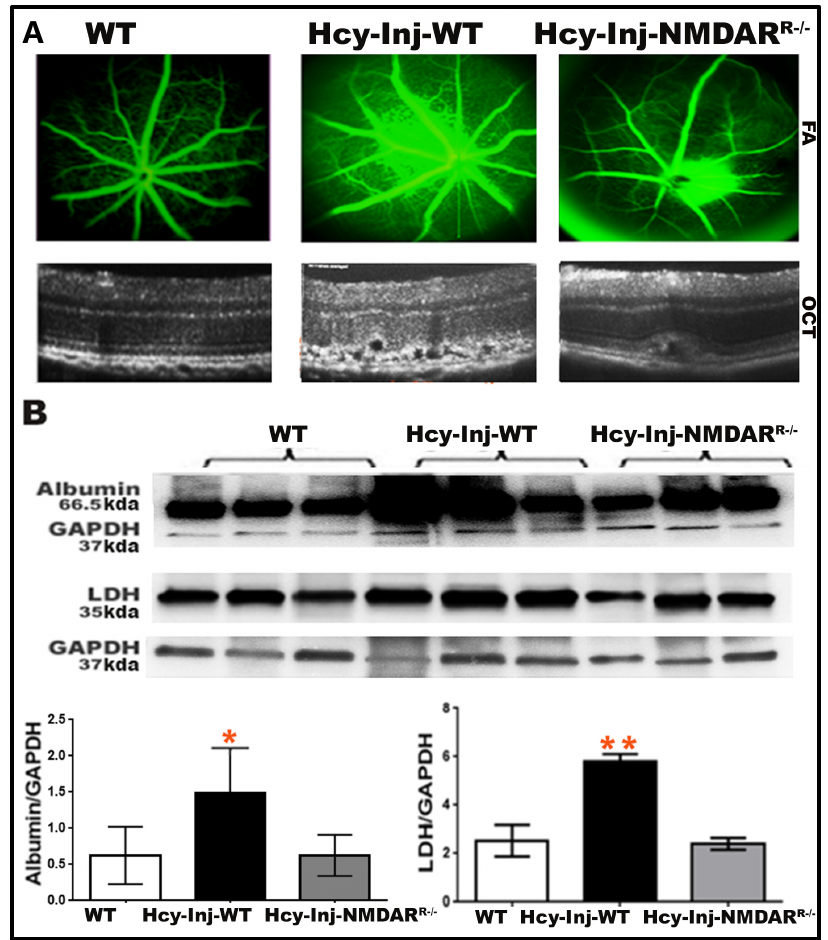
Figure 6. Deletion of NMDAR in RPE cells protected the retina from the harmful effect of Hcy on BRB, CNV induction, and glycolysis activation. ( A ) FA and OCT evaluation of living mice retinas after 72h after the intravitreal injection of Hcy in WT and NMDAR R − / − compared to WT-control non-injected mice. Hcy injection induced BRB dysfunction with increased fluorescein leakage (upper panel) and induced choroidal neovascularization while knocking down NMDAR in ( NMDAR R − / − ), protecting the retina from the Hcy’s harmful effect and reducing the CNV induction (lower panel). B ) Western blot analysis to evaluate albumin leakage and glycolytic enzyme LDH in mice retinas after perfusion of mice with PBS solution. Reduced vascular leakage and glycolysis after blocking NMDAR were confirmed by measuring the albumin leakage and LDH enzyme. Hcy-injection significantly increased albumin leakage and LDH levels in mice eyes, but markedly reduced to normal levels by knocking down NMDAR (in NMDAR R − / − ). GAPDH was used as a loading control. Scale bar: 20 µm. * p < 0.05 and ** p < 0.01 as compared to wild-type and Hcy-injected NMDAR R -/- mice .